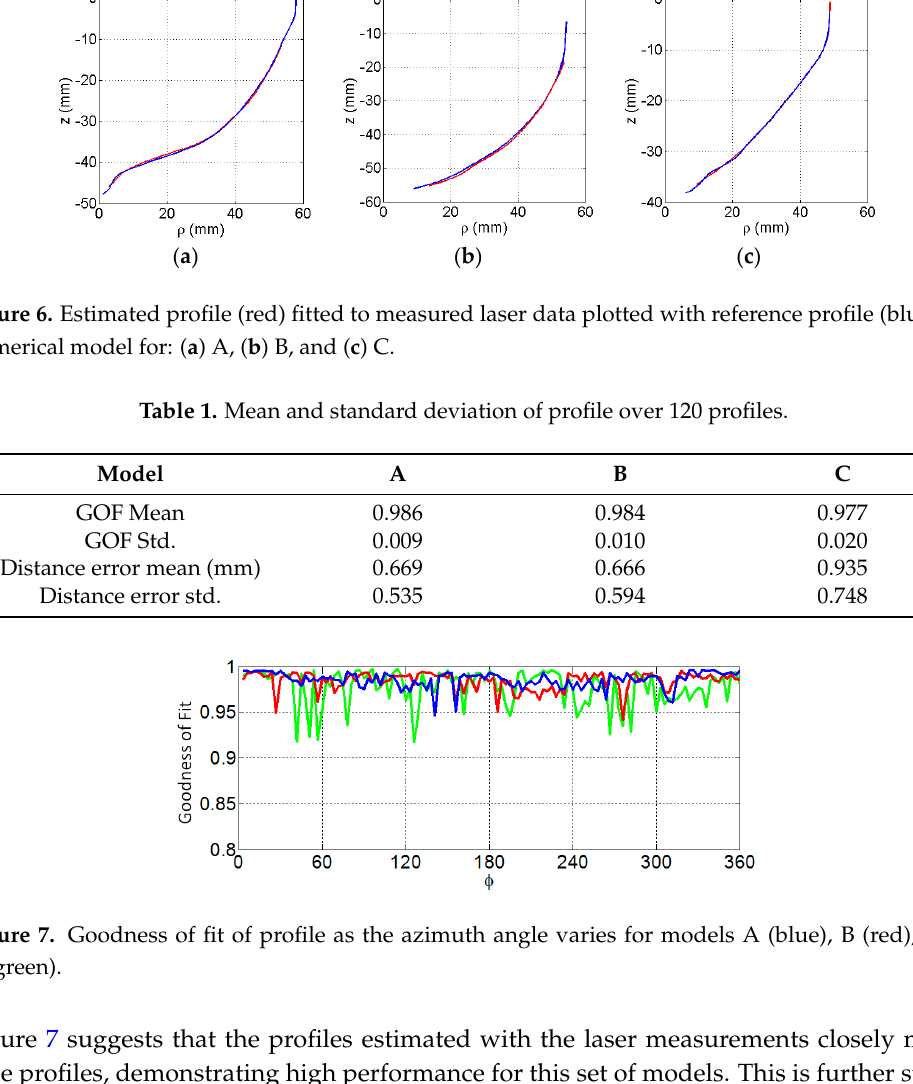
Figure 5. Comparing accuracy and precision between static and dynamic measurements of model B. ( a ) Reference profile (blue) and three set of static measurements (red). ( b ) Reference profile (blue) and 15 sets of dynamic measurements (red). ( c ) Mean static measurement error and max/min error bars. ( d ) Mean dynamic measurement error and max/min error bars.